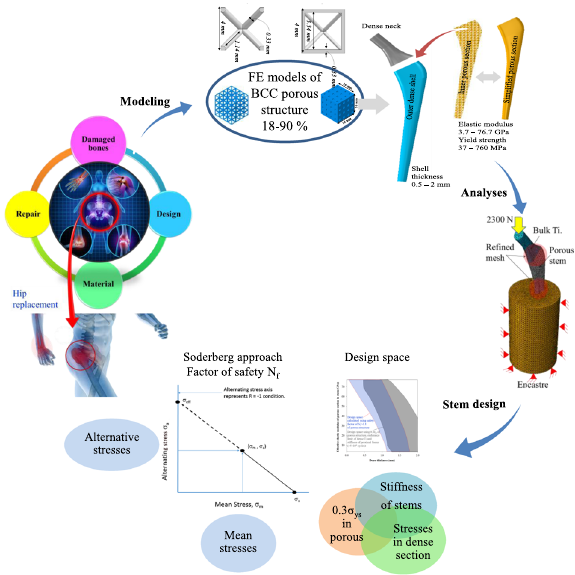
Fig. 1 Schematic delineating the pathway to determine the design of porous